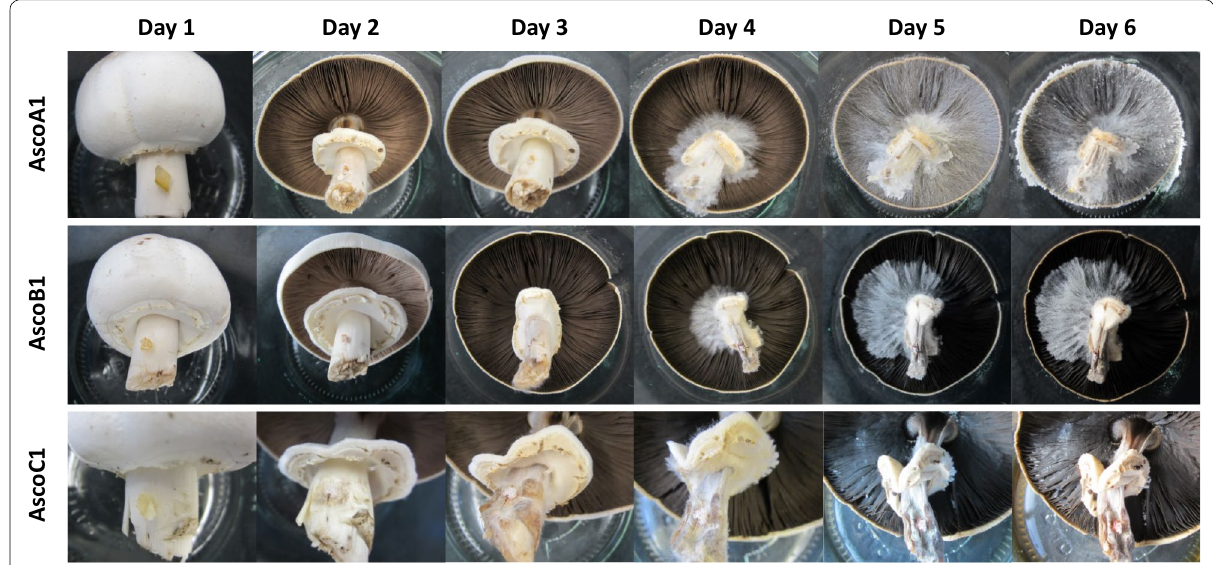
Fig. 8 Young A. xanthodermus fruiting bodies inoculated with H. odoratus strains. Upon stipe inoculation of mushrooms kept within sterile glass jars, the progress in mushroom development and pathogen infestation at RT was photographed once per